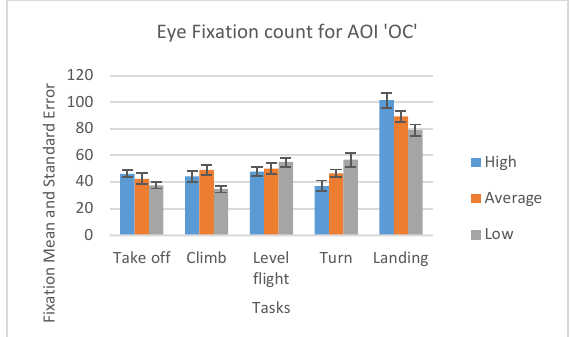
Figure 15. Number of fixations and standard errors AOI ‘AST’ for five flight phases for psychological selection stream.